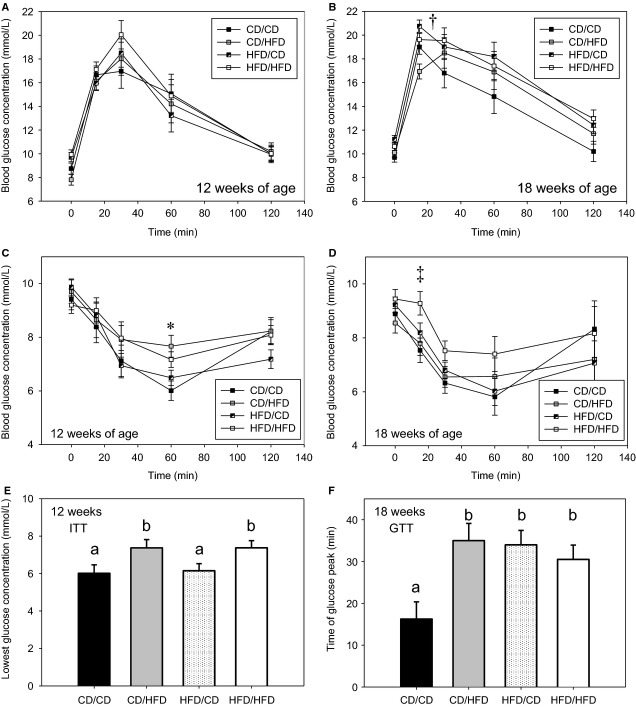
Blood glucose responses to a glucose bolus or insulin challenge administered to F1 male offspring fed a CD/HFD fathered by CD/HFD F0 males. Mean blood glucose responses are depicted for an intraperitoneal glucose tolerance test (GTT) administered at (A) 12 weeks of age; 7 weeks post dietary challenge, (B) 18 weeks of age; 13 weeks post dietary challenge, intraperitoneal insulin tolerance test (ITT) administered at (C) 12 weeks of age; 7 weeks post dietary challenge, (D) 18 weeks of age; 13 weeks post dietary challenge for F1 males, (E) the minimum blood glucose concentration during the ITT at 12 weeks of age and (F) the timepoint at which the peak glucose concentration was achieved during the GTT at 18 weeks of age for the groups CD/CD (CD fed F1 sired by a CD fed F0; n = 7), CD/HFD (HFD fed F1 sired by a CD fed F0; n = 7), HFD/CD (CD fed F1 sired by a HFD fed F0; n = 11) and HFD/HFD (HFD fed F1 sired by a HFD fed F0; n = 11). Data are presented as means ± SEM and different letters/symbols represent statistically distinct groups (P < 0.05). †Delay to peak glucose for CD/HFD, HFD/CD, and HFD/HFD compared to CD/CD (see panel f). *Greater blood glucose concentration at 60 min timepoint for CD/HFD and HFD/HFD compared to CD/CD and HFD/CD (see panel e). ‡Increased blood glucose concentration in HFD/HFD compared to all other groups.